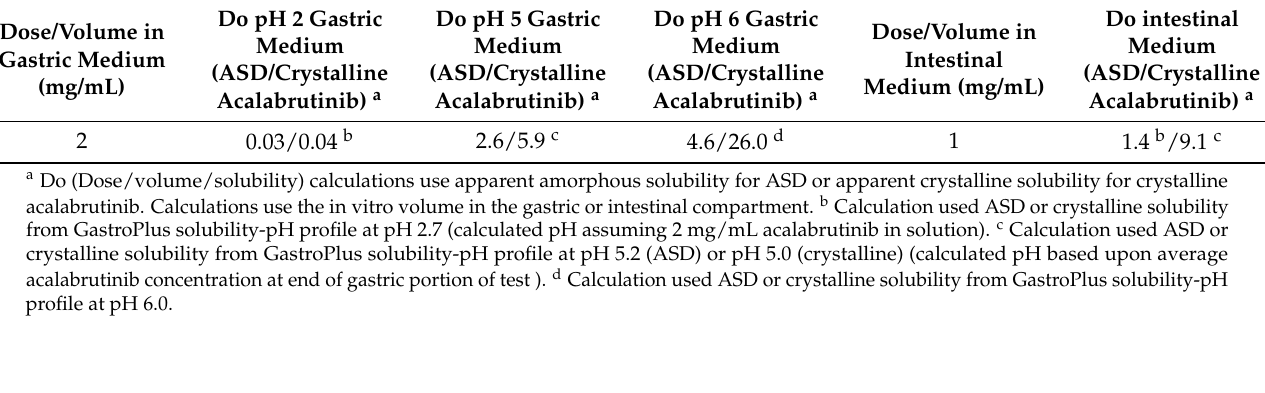
Table A2. Do (Dose number) calculations for gastric to intestinal transfer dissolution test using a Pion µ Diss TM Profiler. Dose/Volume